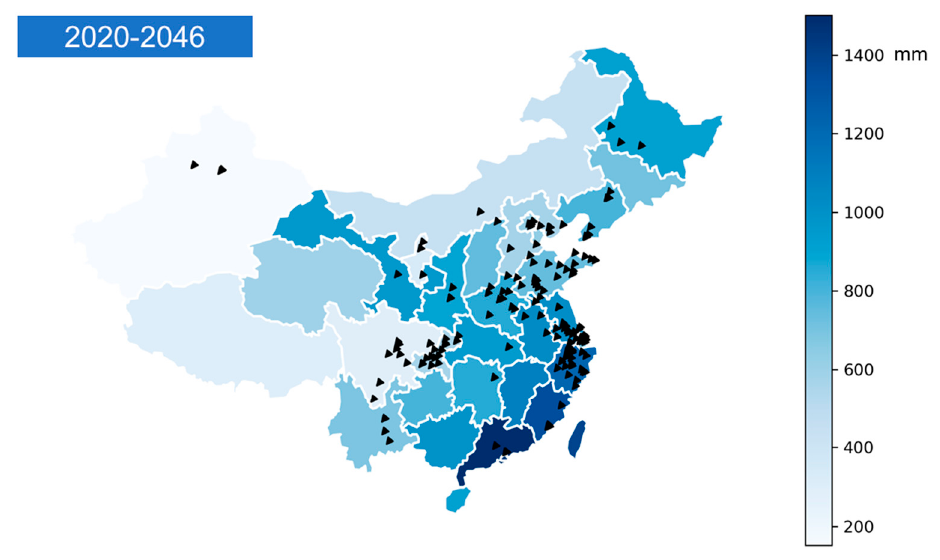
Figure A6. Annual average precipitation levels in short-term future (2020–2046), and locations of wastewater treatment plants included in the sample.